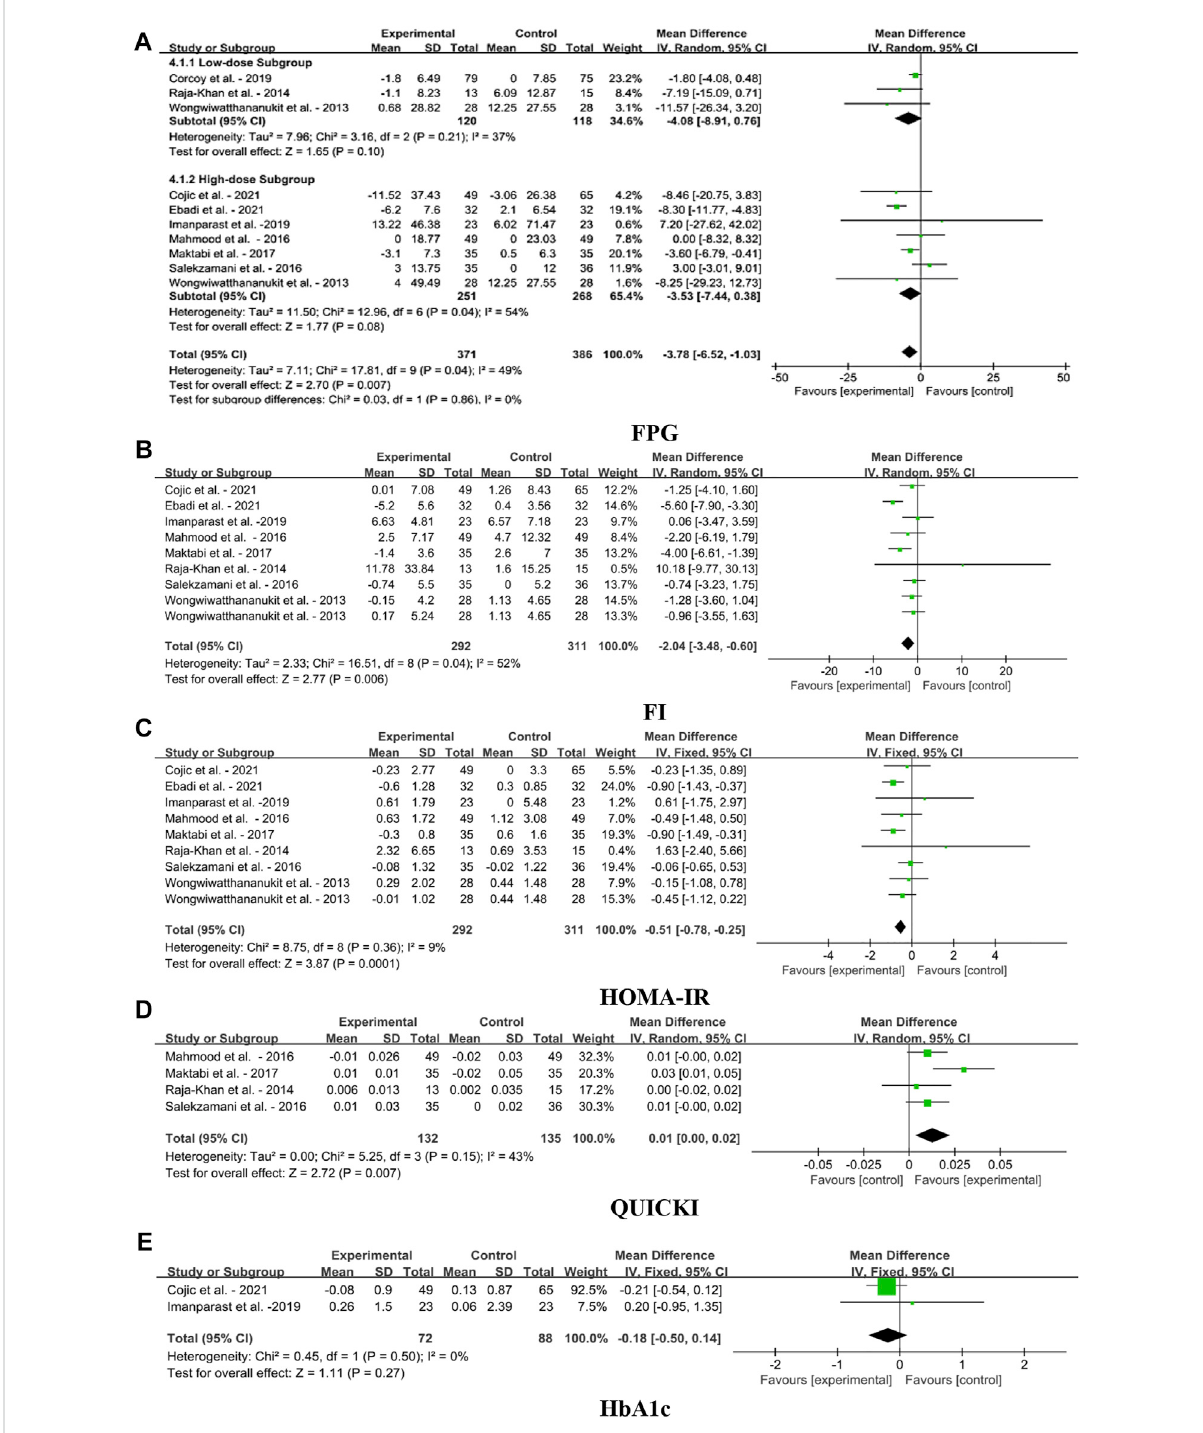
FIGURE 6 ForestplotsfortheeffectsofVDSonserumglycemiaaspectinMetSadults. (A) FPG:fastingplasmaglucose, (B) FI:fastinginsulin, (C) HOMA-IR: homeostasis model assessment of insulin resistance, (D) QUICKI: quantitative insulin check index, (E) HbA1c: glycosylated hemoglobin, type A1C. Thehorizontalbarindicatesthe95%con fi denceinterval(CI).Thesizeoftherectangleatthecenterofthehorizontalbarisproportionaltotheweight of the given study. The diamond at the bottom indicates the pooled mean difference